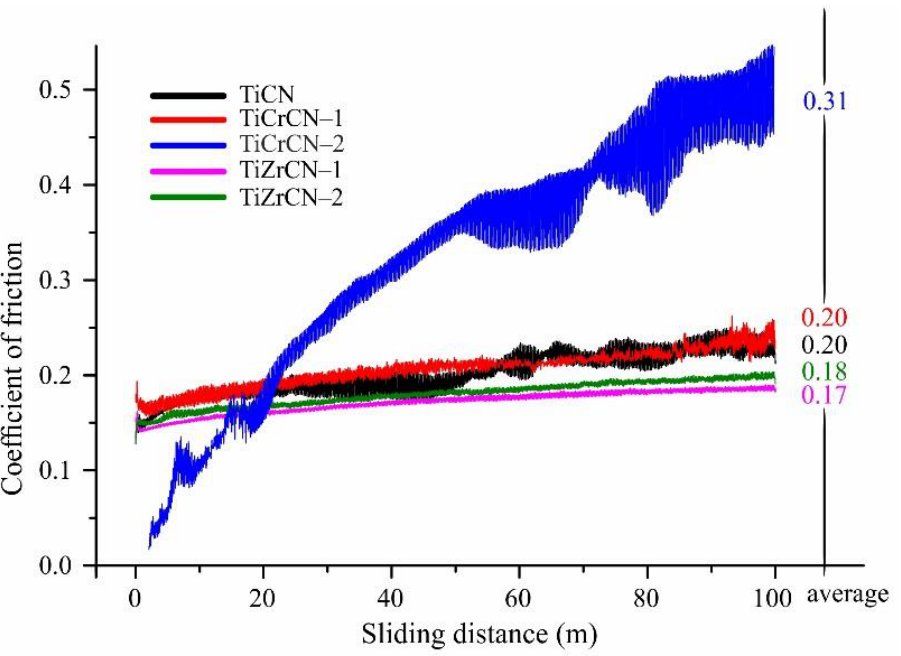
Figure 6. CoF with an average value for TiCN, TiCrCN, and TiZrCN coatings on a titanium VT1-0 substrate.